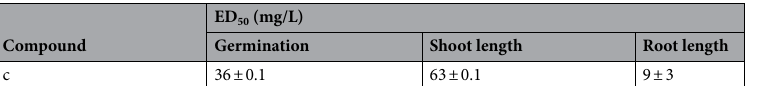
Table 2. ED 50 values of compound c for Eleusine indica after 7 days of treatment with germination test. ED 50 (mean ± standard error) is the dose needed by the compound to reduce germination, shoot length and root length by